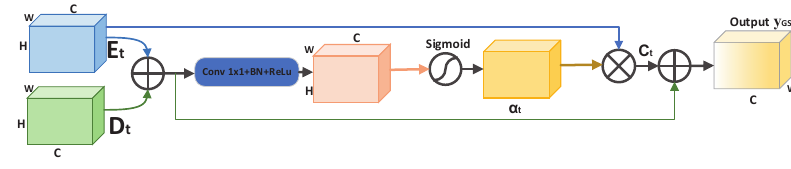
Figure 2. Structure of the gated